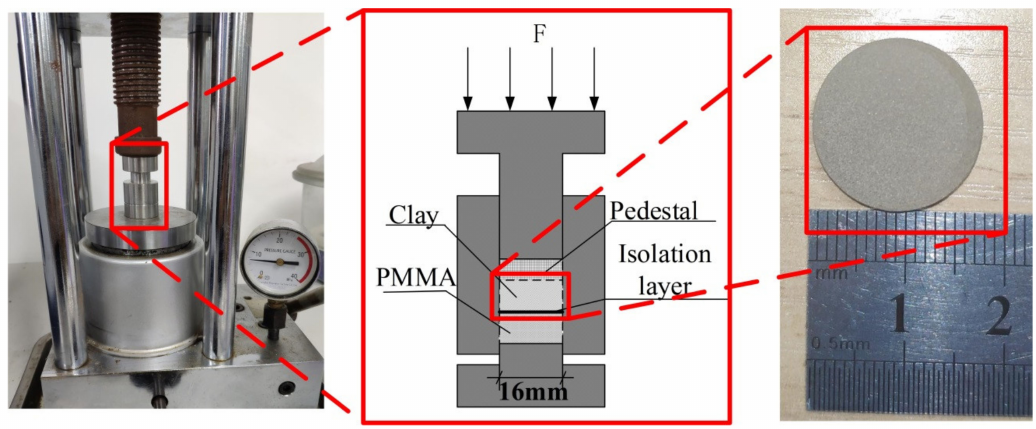
Figure 6. Fabrication of clay soil specimen.